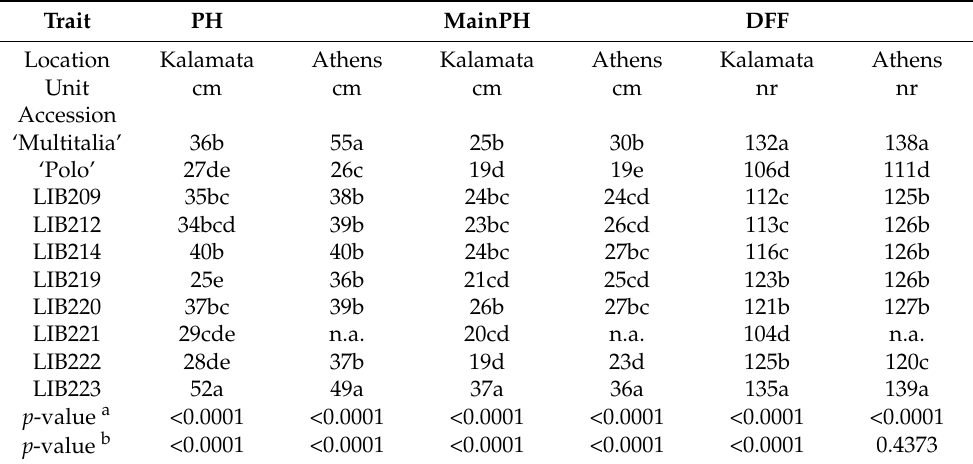
Table 2. Means of PH, MainPH and DFF among L. mutabilis accessions in comparison to white (‘Multitalia’) and narrow-leafed lupin (‘Polo’) in Kalamata and Athens locations. Trait PH